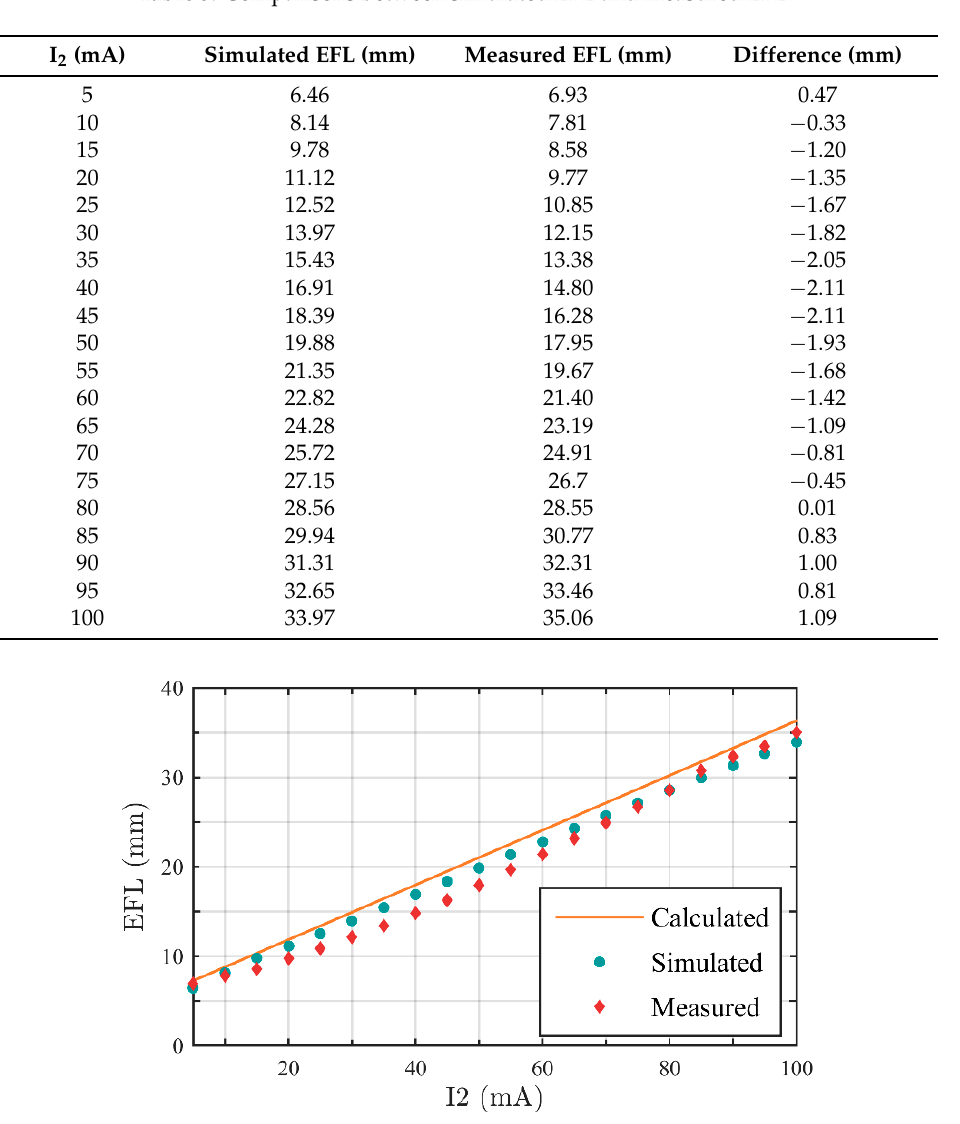
Table 5. Comparisons between simulated EFL and measured EFL.